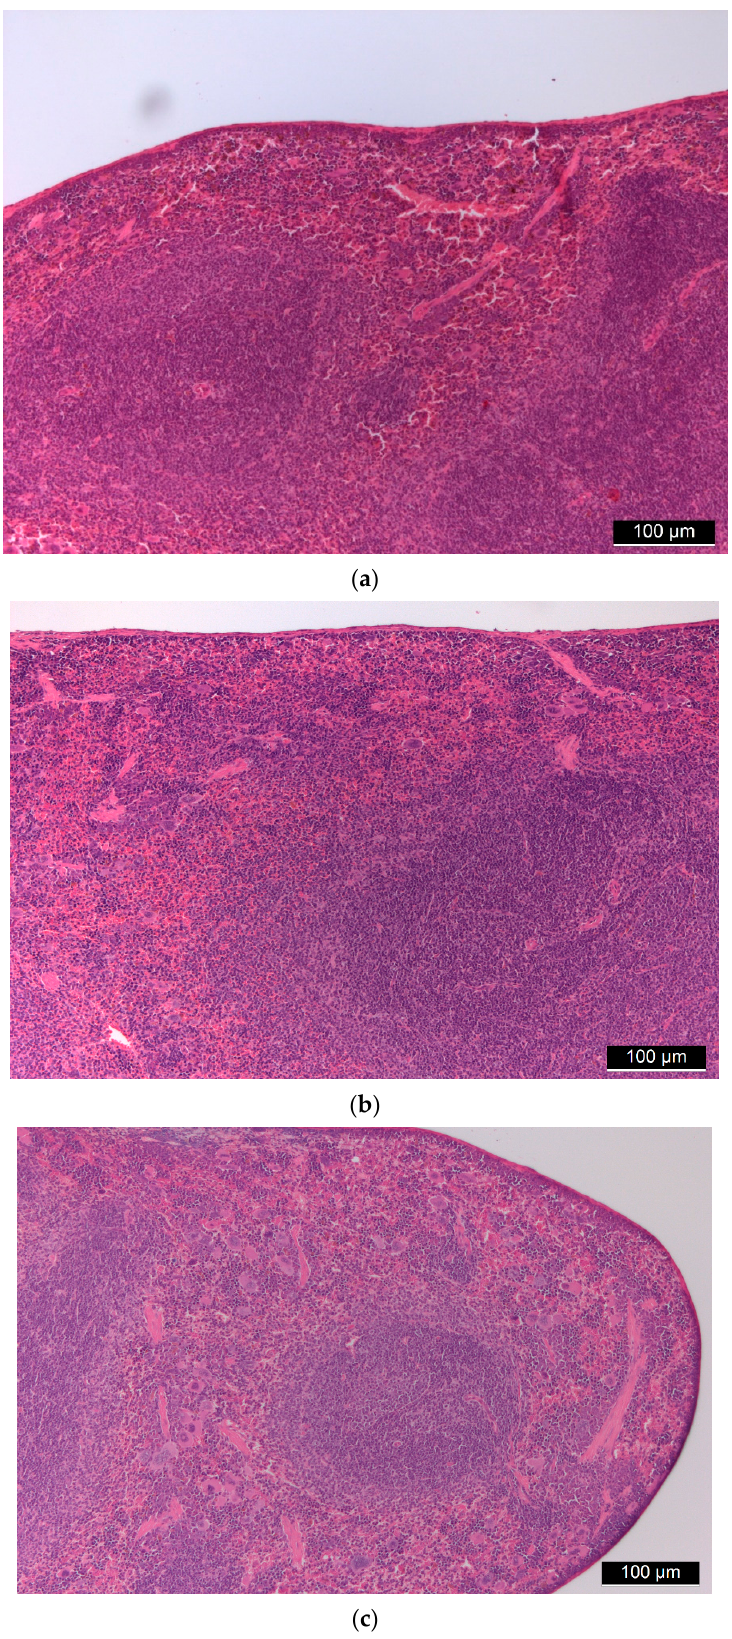
Figure 4. ( a ) Control spleen tissue. ( b , c ): Spleen tissues of “low dose” ( b ) and “high dose” ( c ) FSGM-treated mice.